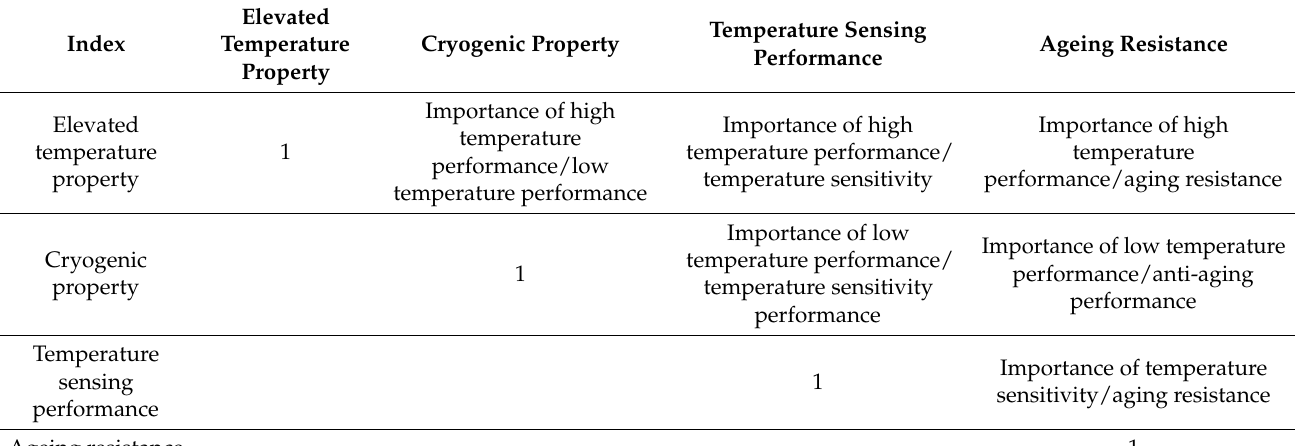
Table 11. Comparison of matrix models.